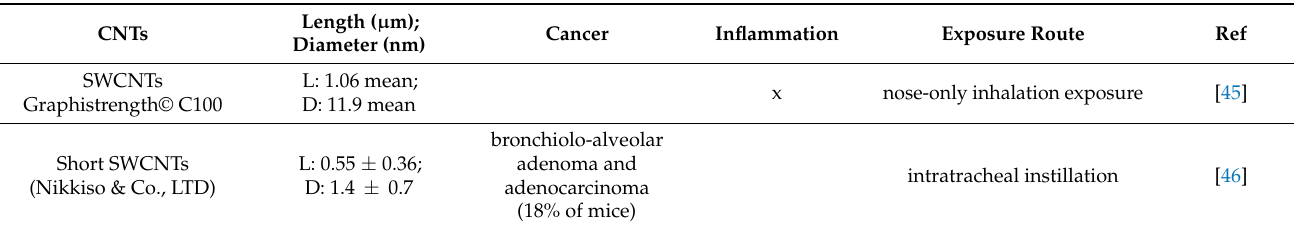
Table 2. Cancer development, histological changes, and inflammatory response observed in in vivo experiments with